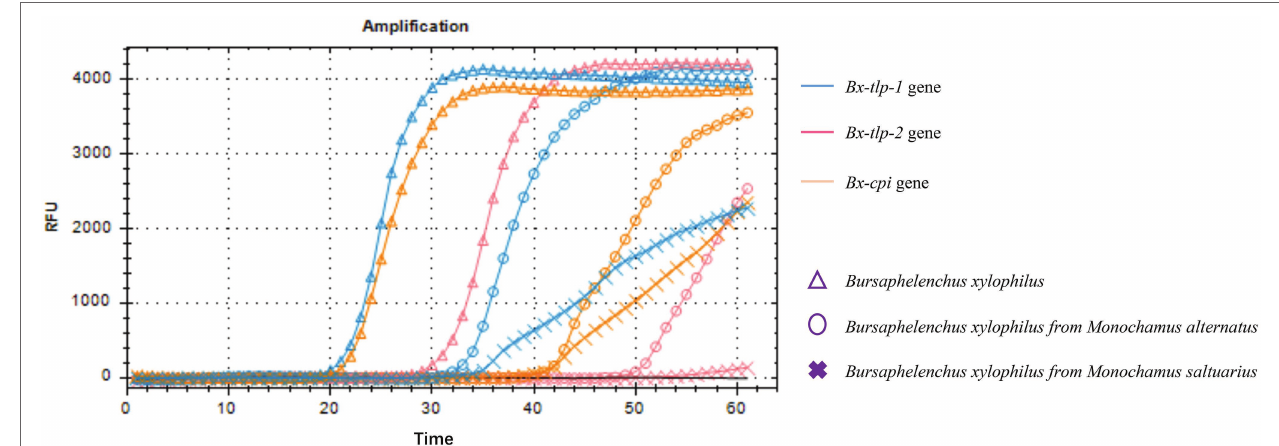
FIGURE 4 | LAMP assay real-time monitoring using a light cycler and a fluorochrome dye.